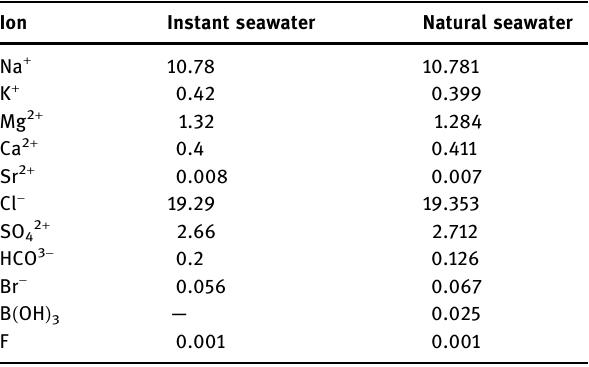
Table 2: Main component of instant ocean water and natural ( Unit: ppt )